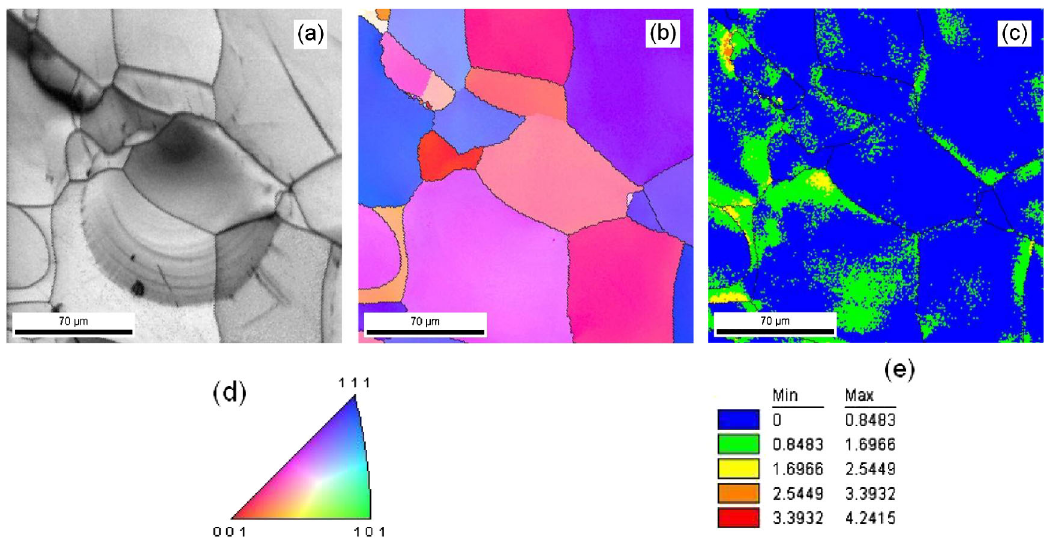
FIG. 13. SEM and EBSD results from pit far from the HAZ, sample #4. ( 200 (cid:2) 200 (cid:1) m , 1 (cid:1) m resolution): (a) image quality map; (b) inverse pole figure (pit near [001]); (c) GROD map; (d) key for (b); (e) key for (c). Maximum lattice rotation rate within pit of (cid:3) 0 : 2 (cid:1) =(cid:1) m . Note ‘‘beach’’